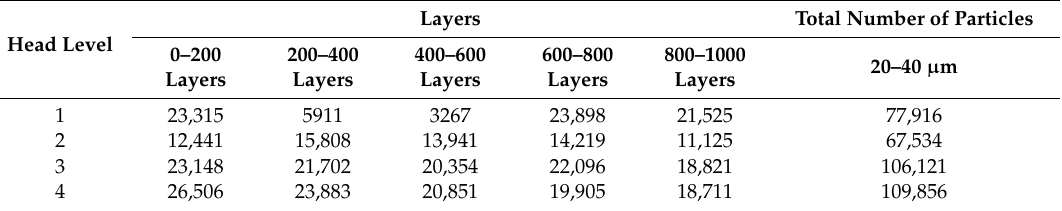
Table 17. Variation in the number of fine particles percolated with the 70% fine particle content (20-40 µ m).